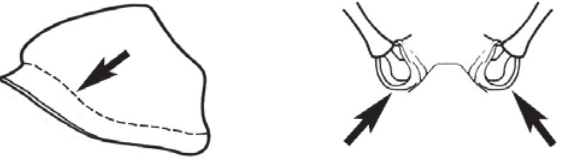
– Pronotum without translucent lamina; if cuticle of mesosoma with dense striolate-microreticulate sculpture, then metanotal groove always present, although it may be reduced to a slight transverse indentation; torulus never pedunculate as above (except in one rare population of M . lanuginosus ) ................................................................................................ 2 Large, oblique propodeal spiracle situated well before declivitous face of propodeum, the spiracle bisecting much of the propodeum; mandible modified in two of the three species (either securiform, its masticatory margin with small to minute, blunt, evenly-sized teeth (except for the long, sharp, apical tooth), or edentate); PF reduced (3,4) in two of the three constituent species ( M . potteri species-group) ...................................................................................................... 3